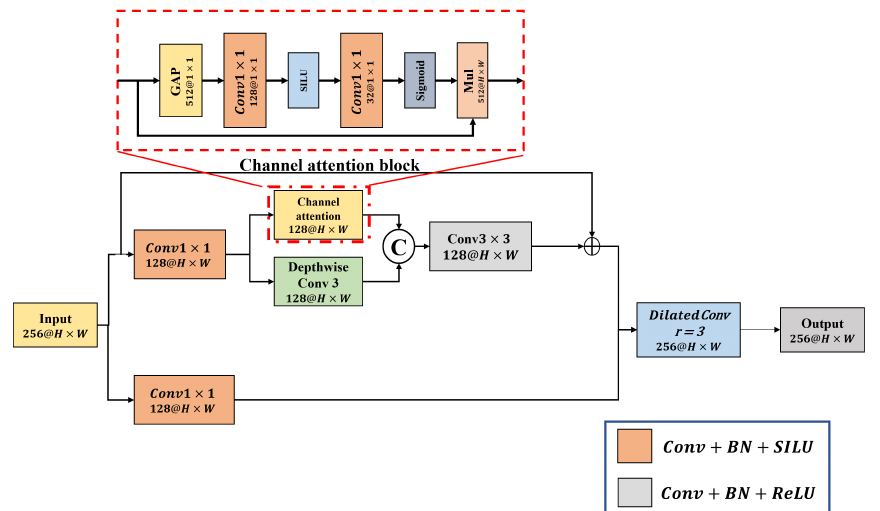
Figure 5. Structure of rebellion stage block. HIS block computes spatial and channel information in parallel to reduce loss of feature, where GAP, BN, ReLU, and SiLU represent the global mean pooling, batch normalization, modified linear unit, and sigmoid linear unit activation functions,